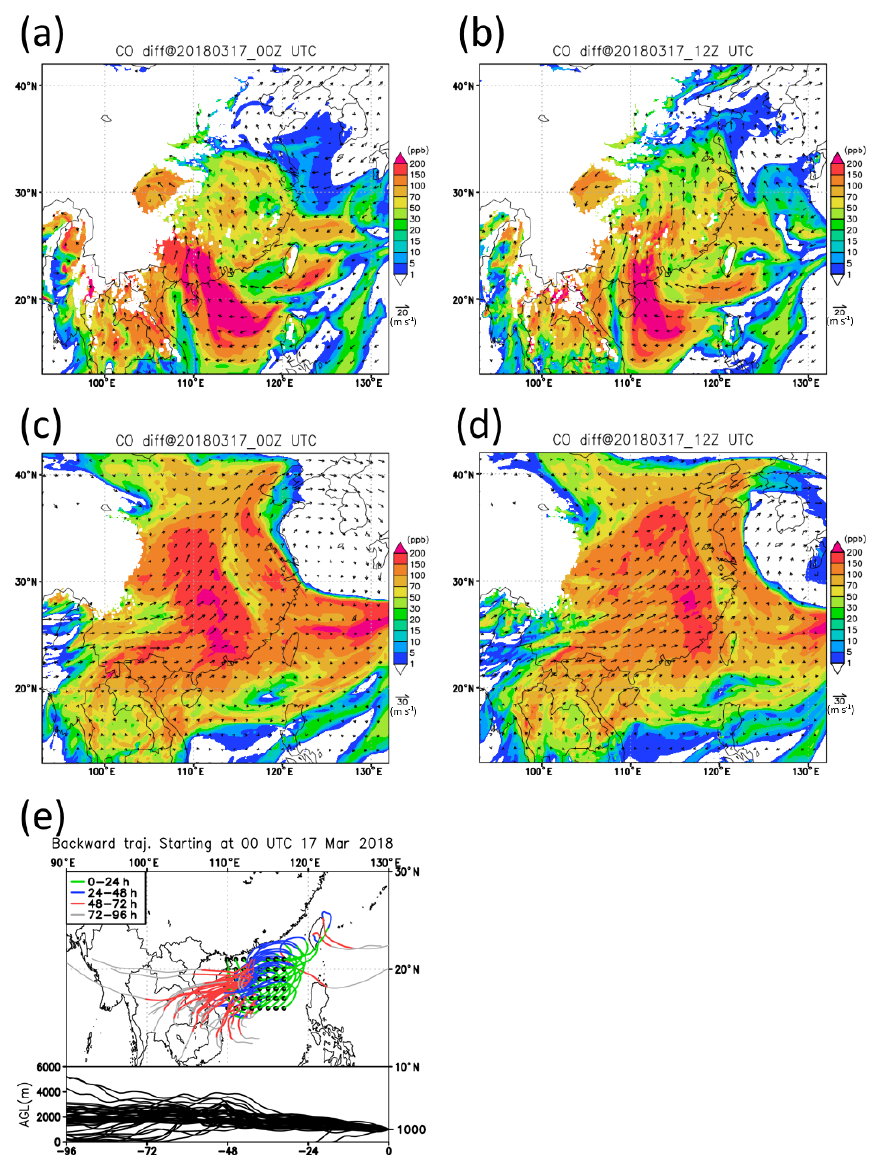
Figure 3. Simulated wind field (ms − 1 ) distribution and concentration (unit: ppb) difference with and without BB emission for CO on 17 March 2018 at 00:00UTC (a, c) and 12:00UTC (b, d) at a 1km altitude (a, b) and 3km altitude (c, d) (unit: ppb). (e) The results of the HYSPLIT model backward-trajectory analysis at 1000m with multiple points by 1 ◦ × 1 ◦ in the area (17.5–22.5 ◦ N, 110–115 ◦ E) of the East China Sea started at 00:00UTC, 17 March